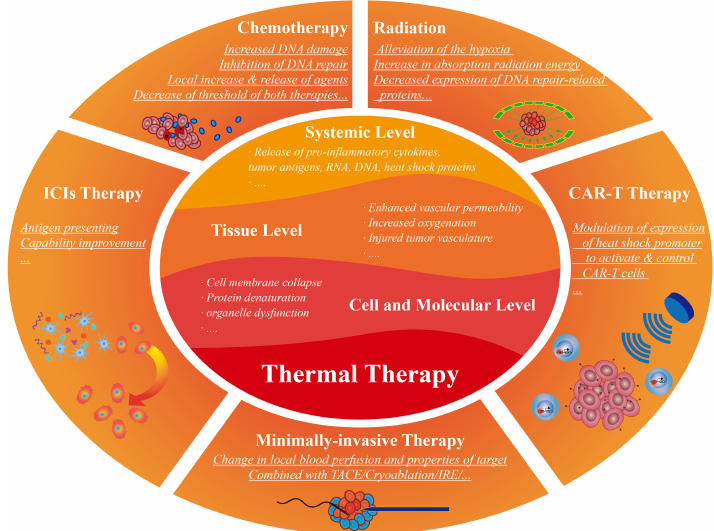
Figure 1. The schematic diagram of synergetic thermal therapies. The effects of thermal therapy can be divided into the cell and molecular level, tissue level, and systemic level. Due to these effects, thermal therapy is combined with chemotherapy, radiation therapy, immunotherapy, and other minimally-invasive therapy, realizing unique enhancements